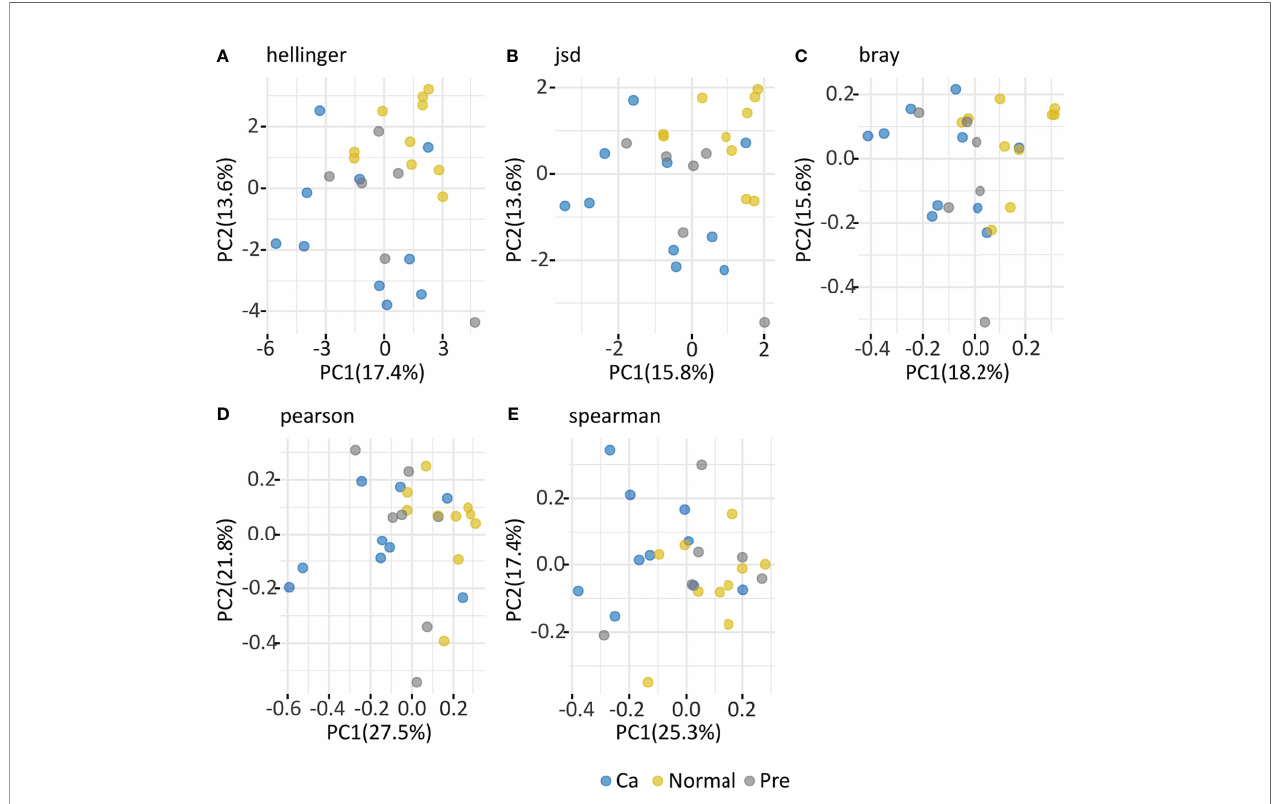
FIGURE 4 | In the fi gure depicting Principal co-ordinates Analysis (PCoA), blue dots represent a gargle sample from the oral cancer group, yellow dots represent a gargle sample from the normal group, and gray dots represent a gargle sample from the precancerous group. A dot represents a sample, with similar samples arranged closer to each other. (A) Hellinger index; (B) Jsd index; (C) Bray index; (D) Pearson index; (E) Spearman